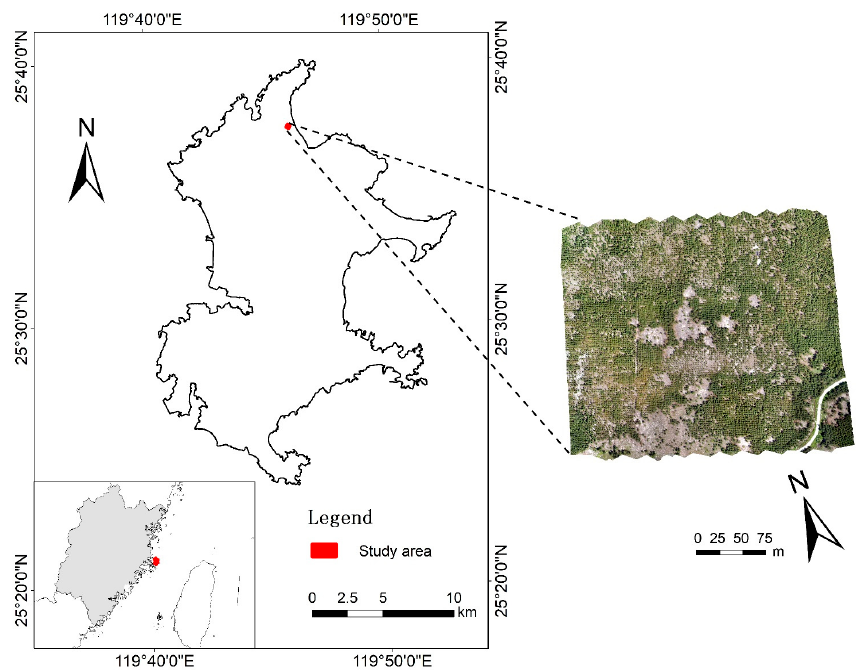
Figure 1. Location of the study site, Pingtan, Fujian, China.